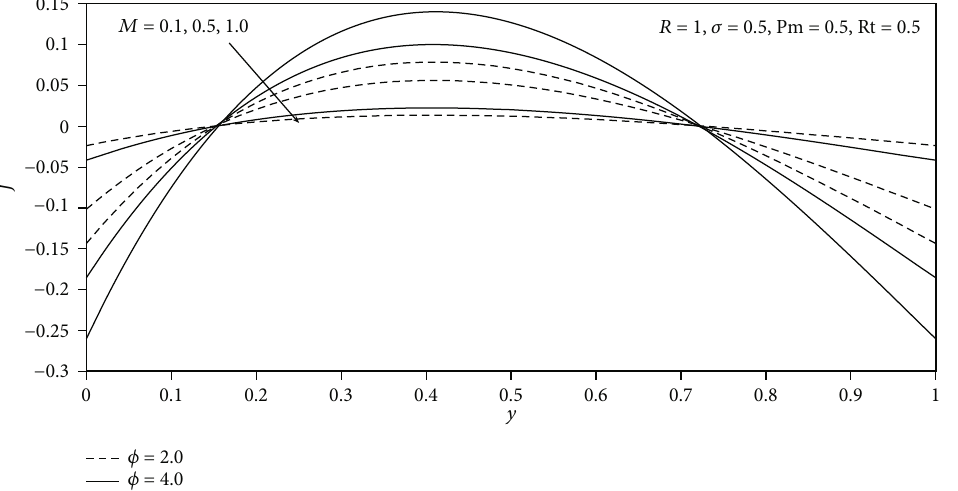
Figure 11: Induced current density for di ff erent values of M and ϕ .